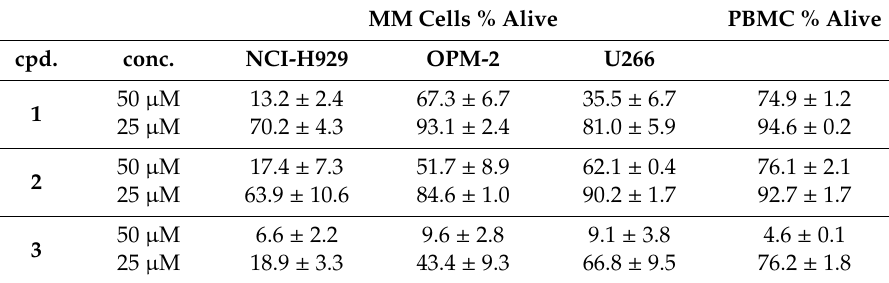
Table 2. Cytotoxicity of compounds 1 – 3 after incubation for 48